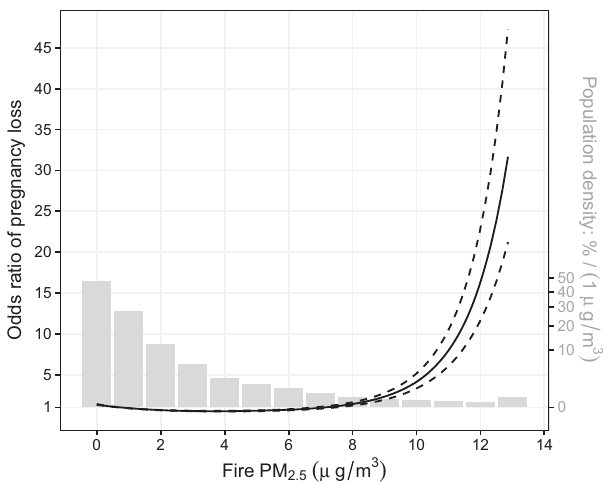
Fig. 4 Estimated nonlinear associations between open fi re PM 2.5 and pregnancy loss. Concentrations of fi re PM 2.5 were assessed by the GEOS- Chem model, and the associations were adjusted by maternal age, temperature, humidity, temporal trends, and non- fi re PM 2.5 . The estimates are derived from the full-adjusted model with 24,876 independent mothers. The solid line denotes point-estimates of the nonlinear association, and the dashed lines denote the corresponding point-wise 95% con fi dence intervals. PM 2.5 particulate matter with a diameter of less than 2.5 µ